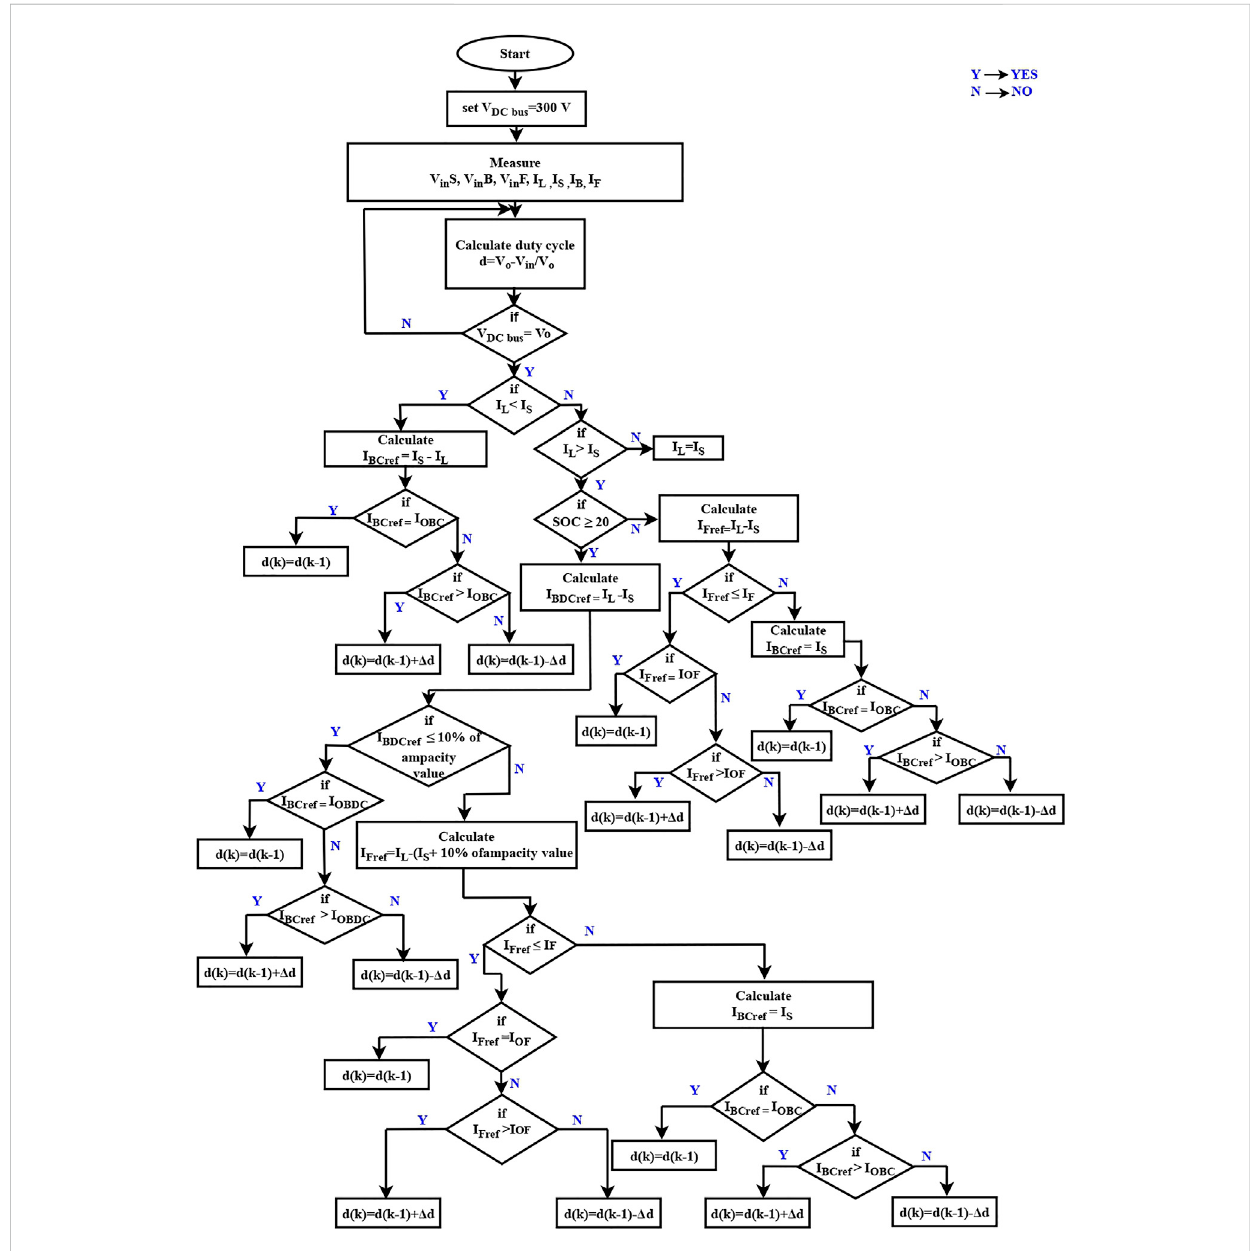
FIGURE 8 Flow chart for digital